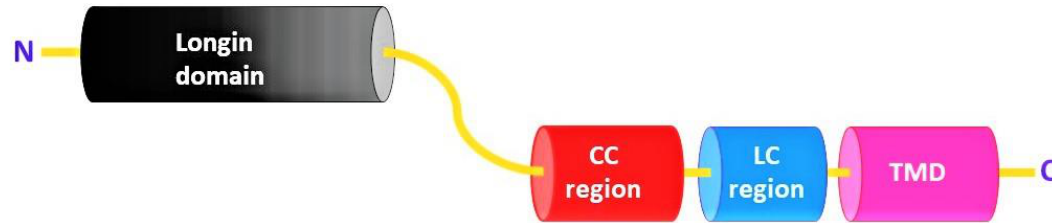
Figure 2. Schematic representation of Sec22 with N-terminal Longin domain, coiled-coil region (CC), low-complexity region (LC), and its C-terminal transmembrane domain (TMD).